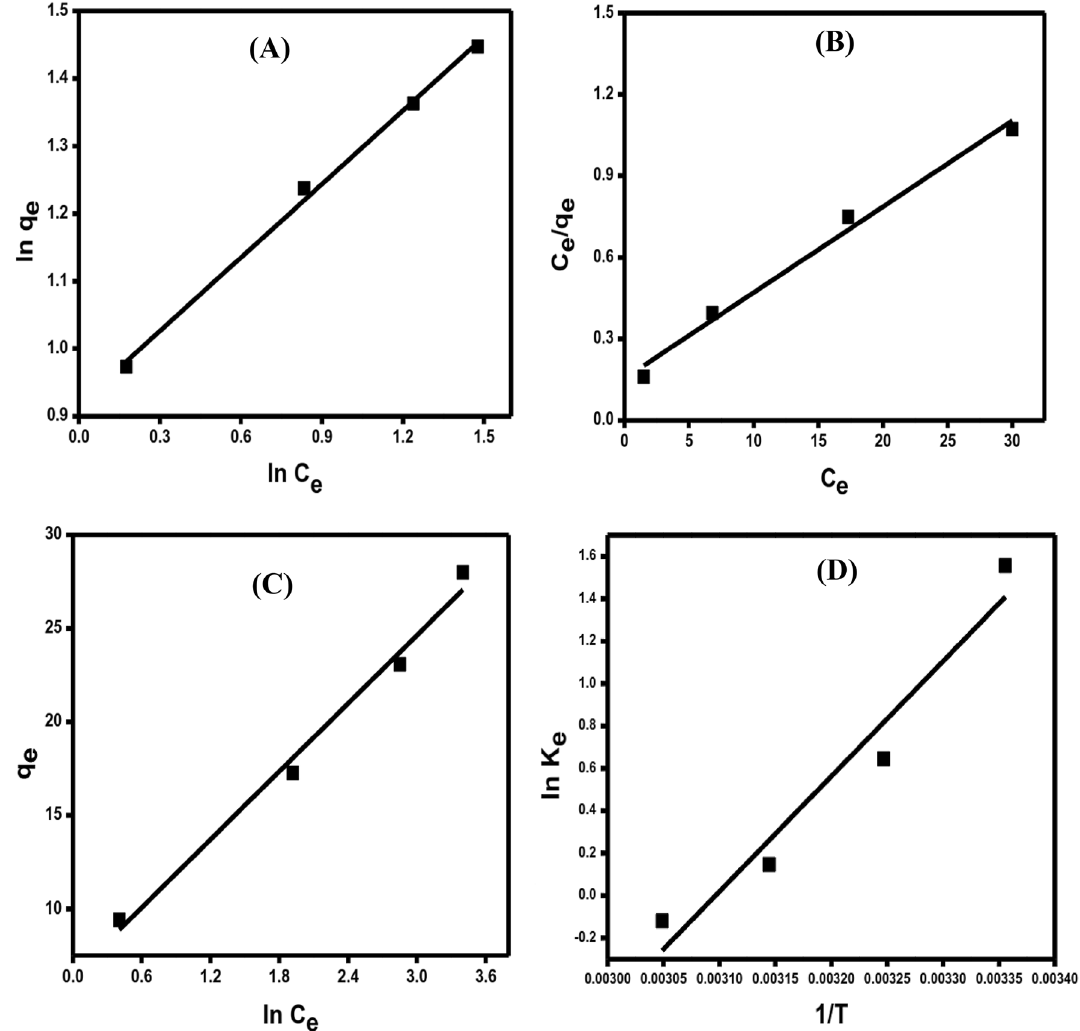
Figure 9. linear adsorption isotherm plots of Freundlich ( A ), Langmuir ( B ), and Temkin ( C ) [C o = 25–100 mg L −1 , pH = 7, T = 25 °C, and dose = 0.05 g]. Plot of Vant Hoff equation for the adsorption of DC onto rGO/nZVI composite ( D ) [C o = 25–100 mg L −1 , pH = 7, T = 25–55 °C, and dose = 0.05